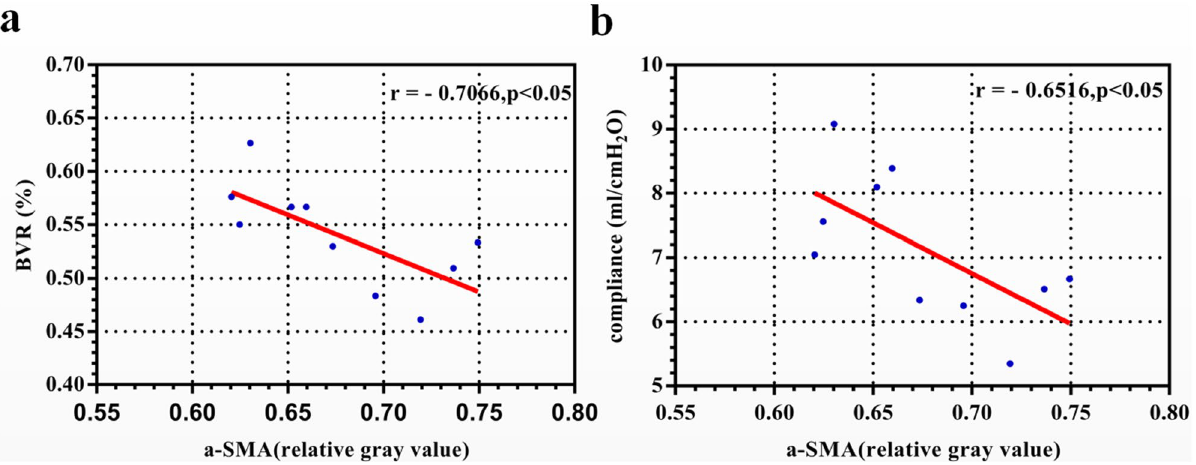
Figure 4. Correlation between the expression of α-SMA and BVR ( a ) or △ C ( b